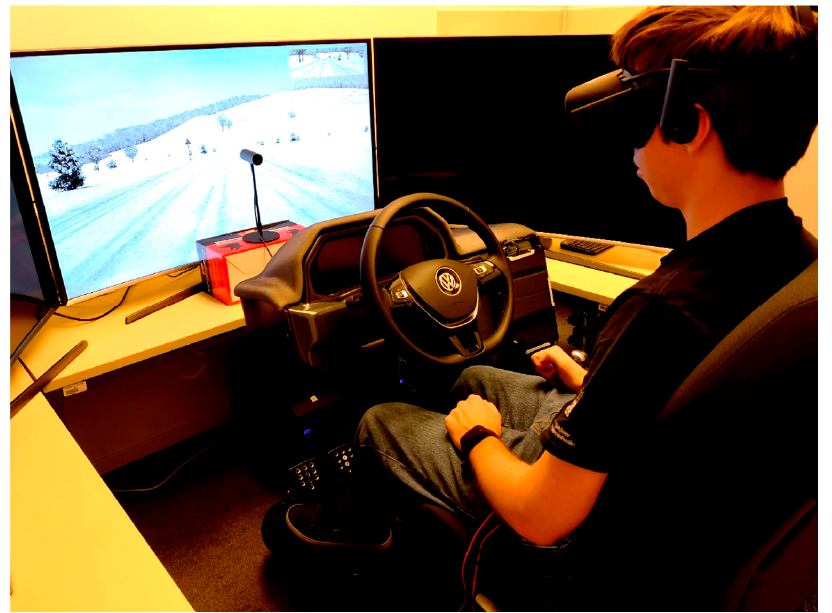
Figure 1. Illustration of the Nervtech driving simulator interior. Image is distributed under the Cre- ative Commons Attribution License and taken from the study by Gruden et al. [4]. The driving simulation consisted of a less dynamic drive, which took part on a high- way road and a more dynamic drive, which took part on a countryside road. The duration of each driving scene was approximately 7 min. The screenshots of the highway and coun- tryside roads are given in Figure 2. The user study had a within-subject design as the participants’ state was measured before, during, and after AV driving simulation. Figure 2. Screenshots of the driving scenarios employed in this study. Left: highway with low traffic; right: country road with many vehicles and icy roads. Image is distributed under the Creative Com- mons Attribution License and taken from the study by Gruden et al. [4]. In order to induce higher levels of sickness and at the same time to reduce the poten- tial and exaggerated EGG artifacts originating from motion or steering, fully autonomous driving was used (SAE level 5) [42]. The participants’ primary task was, therefore, only to observe the autonomous driving. Five Ag/AgCl surface electrodes (H92SG, Kendall/Covidien, Dublin, Ireland) were placed on the participants’ stomach to measure three-channel EGG following the recom- mendations [33,43,44]. The EGG signal was recorded using an amplification and filtering device [10] and digitized using Biopac UIM100C MP150 Analog-to-Digital Converter